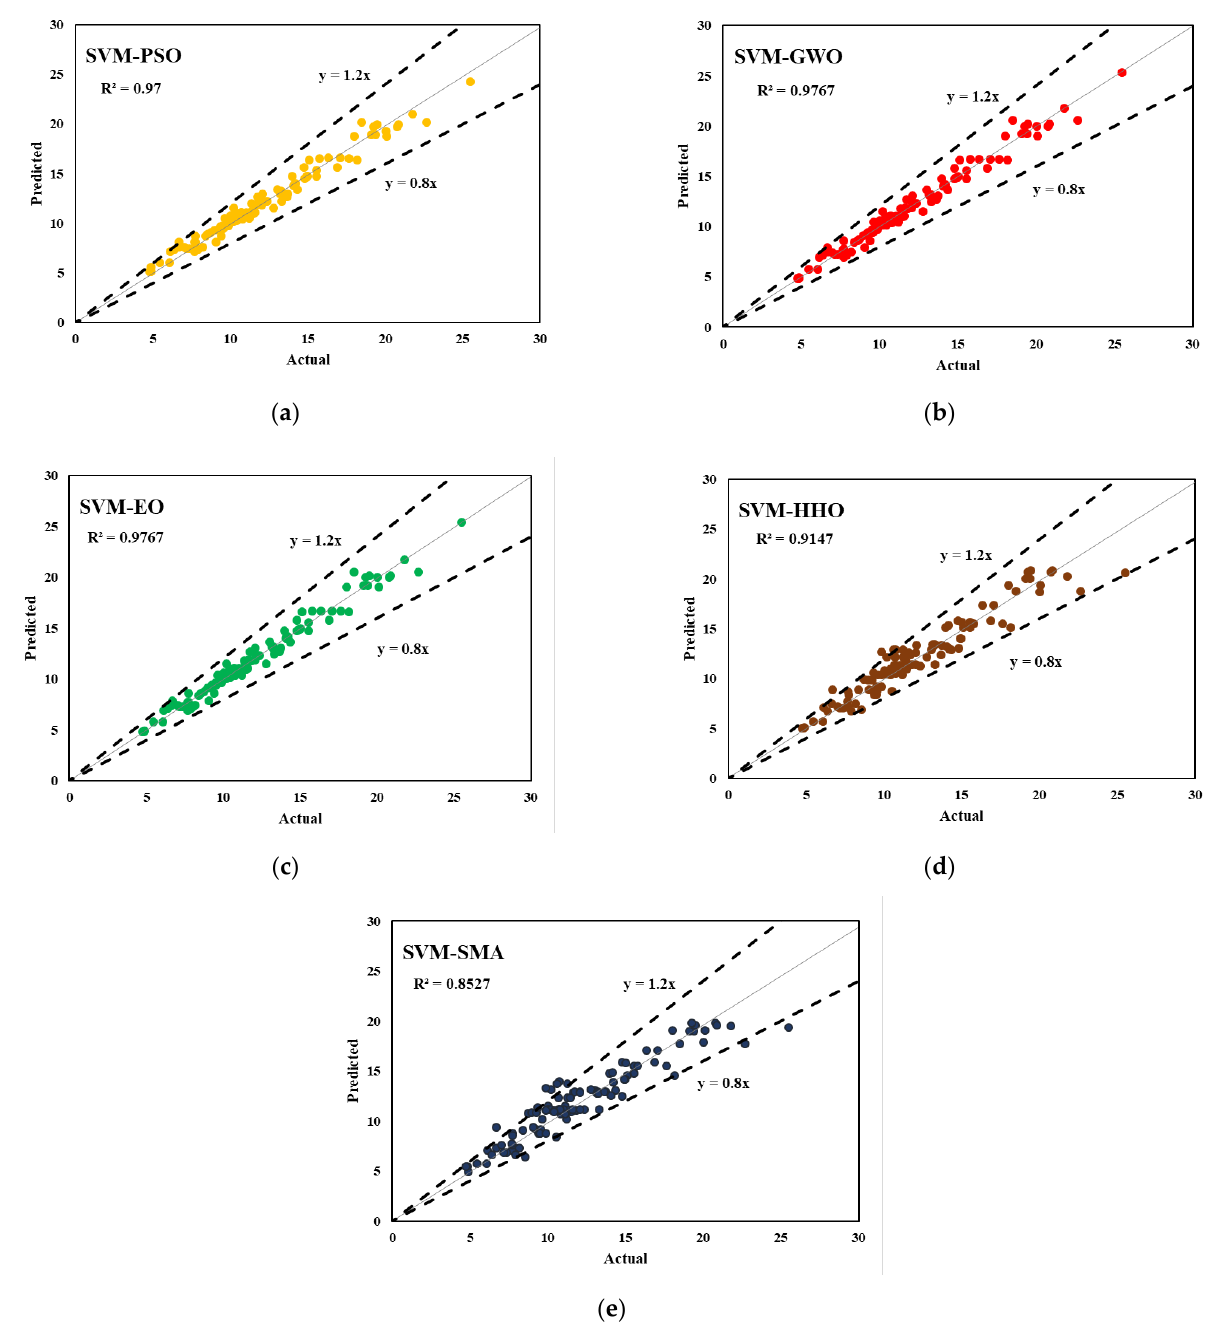
Figure 5. Actual vs. predicted graphs for the training dataset; ( a ) SVM-PSO ( b ) SVM-GWO ( c ) SVM-EO ( d ) SVM-HHO ( e ) SVM-SMA.